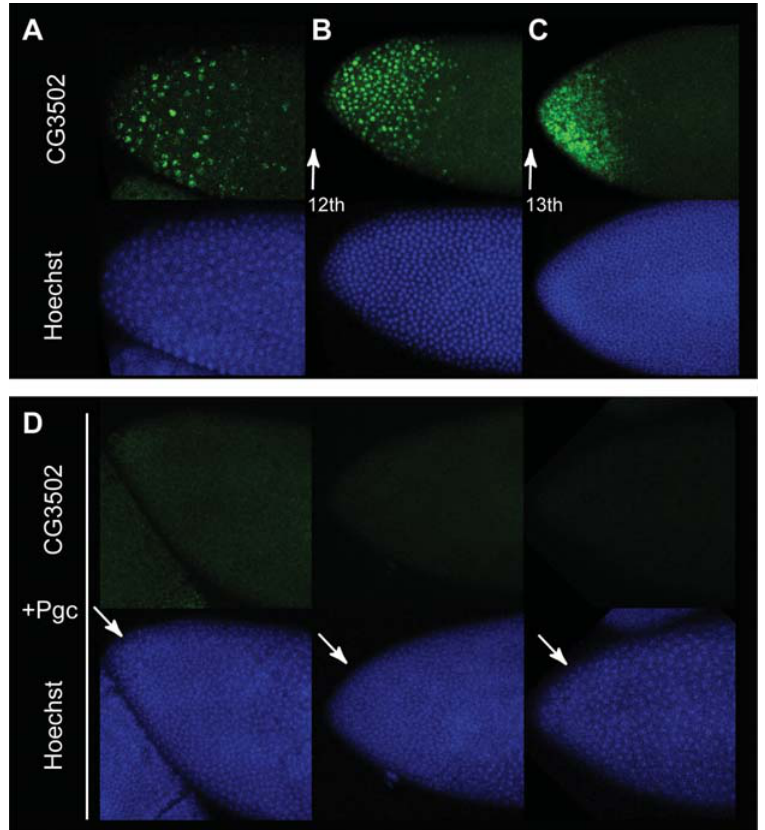
Figure 4. The 71-residue Pgc oligopeptide readily suppresses an early zygotic transcript in Drosophila somatic nuclei. (A) Fluorescent in situ hybridization with an antisense RNA probe for CG3502 , a transcript in the anterior region of the embryo whose expression starts during the 11 th cleavage cycle. CG3502 mRNA accumulates in the nucleus before the 13 th cleavage division (A, B) and redistributes to the cytoplasm during cellularization (C). (D) No detectable CG3502 mRNA one hour after purified Pgc is injected into the anterior region of the embryo. The three representative embryos are developmentally beyond the 11 th cleavage division and should thus be expressing CG3502 .